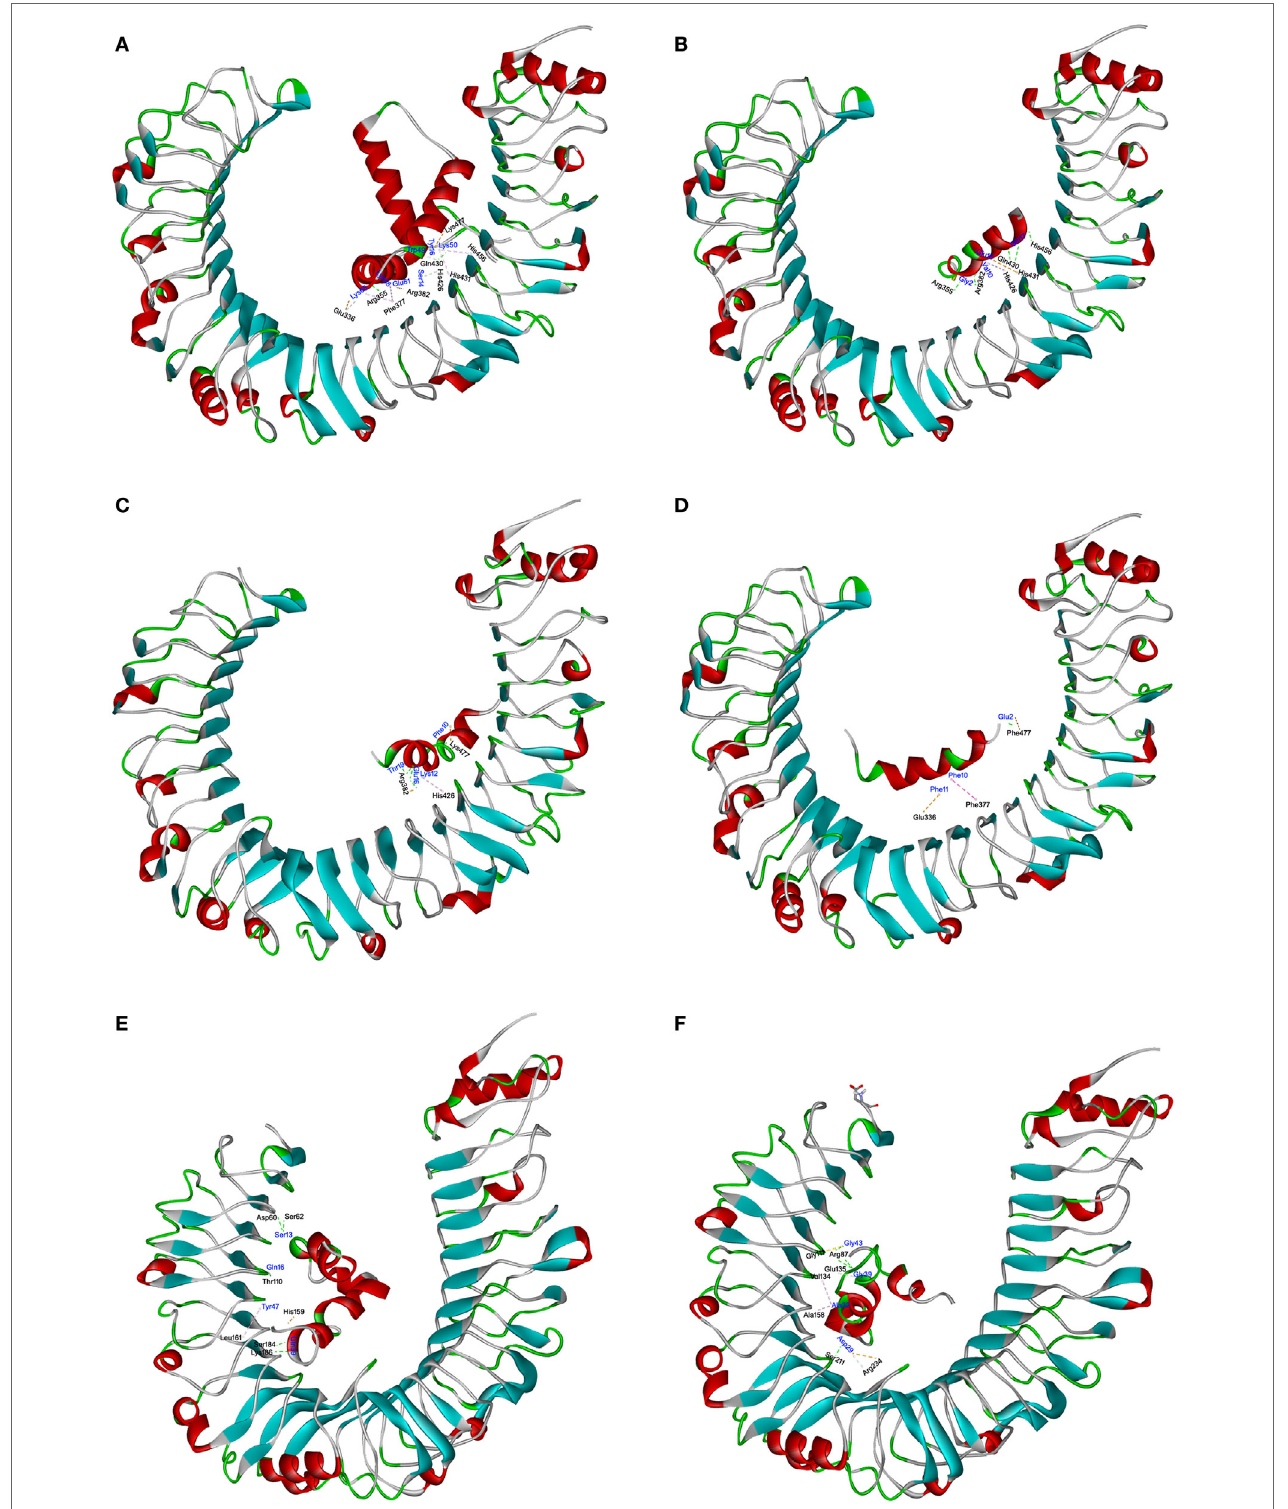
FigUre 6 | The interactions of toll-like receptor (TLR) 4 with HMGB1 and Staphylococcus aureus phenol-soluble modulins (PSMs). The molecular interactions of human TLR4 (hTLR4) with HMGB1 (a) , PSM α 1 (B) , PSM α 2 (c) , PSM α 3 (D) , PSM β 1 (e) , and PSM β 2 (F) were shown as dashed lines with π – π , π –alkyl, and hydrogen bonds colored purple, pink, and green. The secondary structural elements were depicted as ribbons (coils, α -helices; arrows, β -sheets). Color was based on the secondary structures ( α -helices, red; β -sheets, sky blue; loops, green). Residues from hTLR4 and ligands were labeled in black and blue, and shown as lines with carbon, oxygen, and nitrogen colored gray, red, and blue,